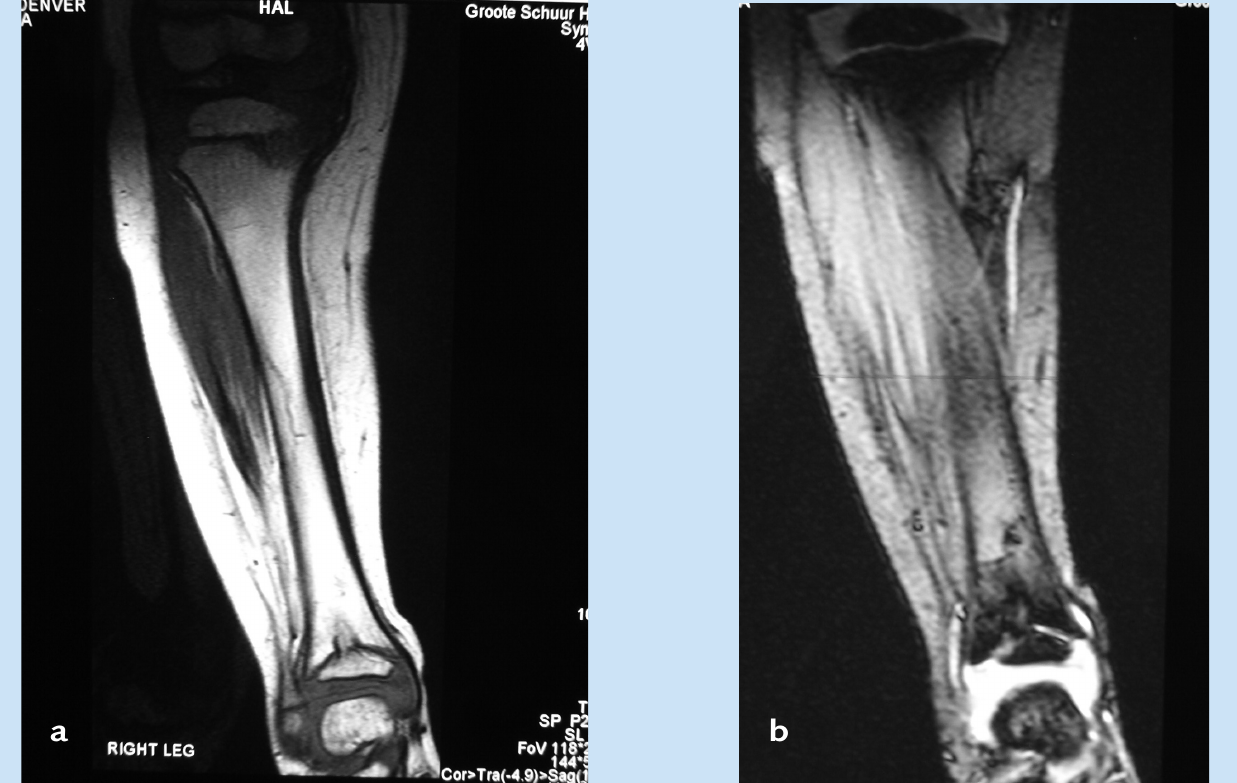
a Fig. 5. Postmeningococcal physeal bar. (a) T1-weighted coronal sequence demonstrates both proximal and distal tibial physeal bars. At the proximal physis there is irregularity and discontinuity medially. At the distal physis a continuous physeal bar containing fatty marrow signal is present. (b) The gradient echo sequence confirms the central continuous bar at the distal tibia by showing discontinuity of the normal physeal high signal.